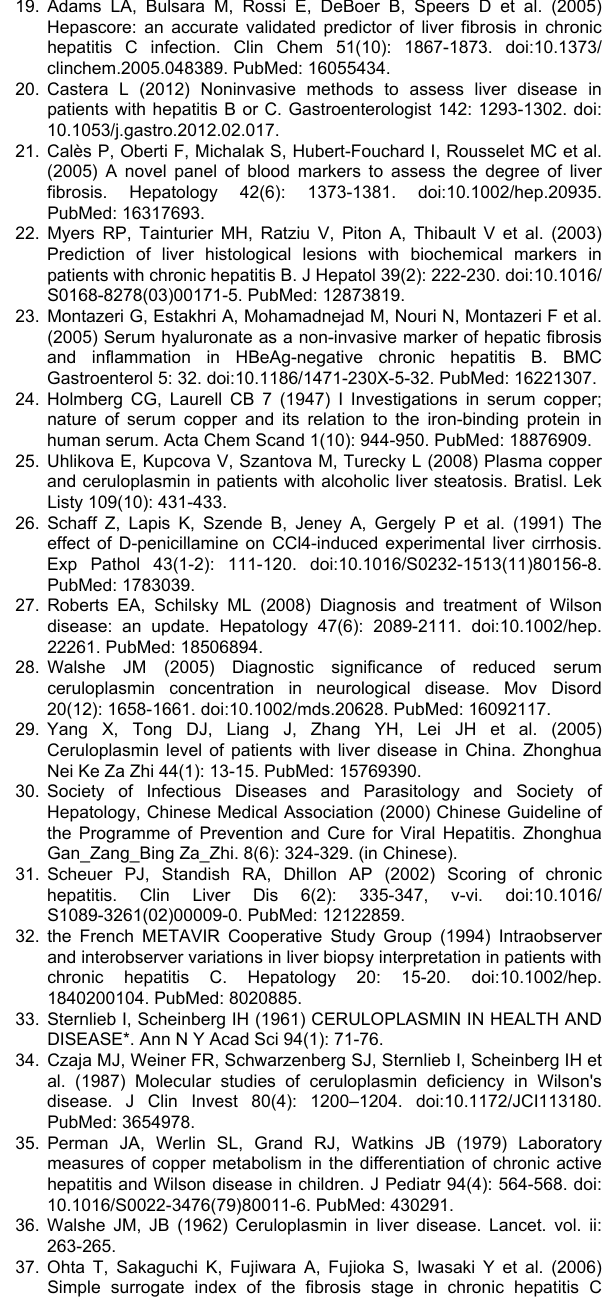
Figure S1. Individual ROC curves for all serum markers in the APPCI model. (TIF) Table S1. AUC values of APPCI and CP alone for determinations of F2, F3 and F4 versus